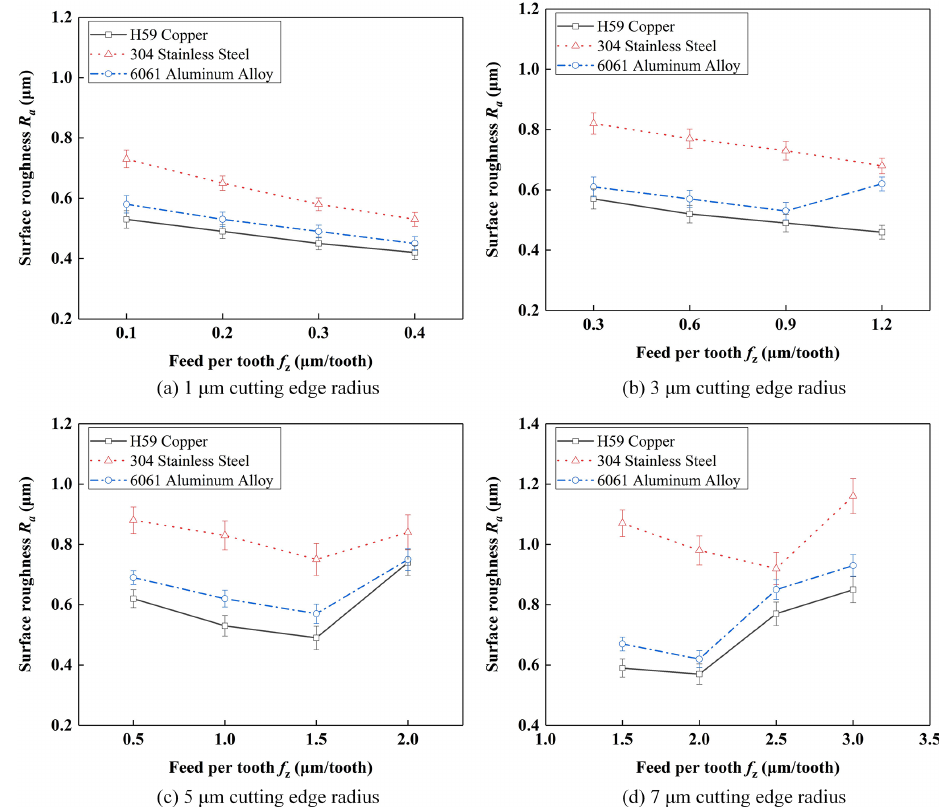
Figure 11. Surface roughness results for the peripheral cutting edge (process no. 1). Table 7. MUCT analysis results of the peripheral cutting edge. MUCT by the MUCT by the MUCT by the chip morphology milling force surface roughness (µm) (µm) (µm) Peripheral cutting H59 copper 304 stainless steel 6061 aluminum alloy edge